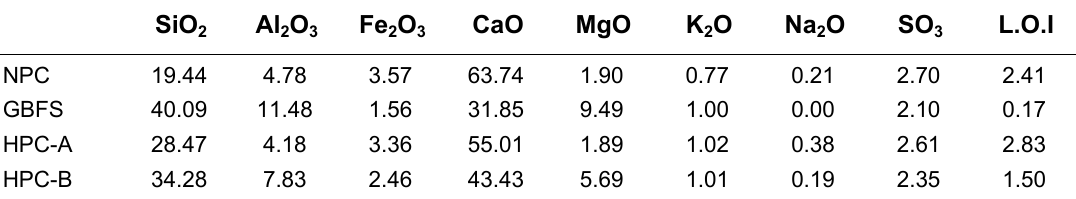
Chemical Composition of